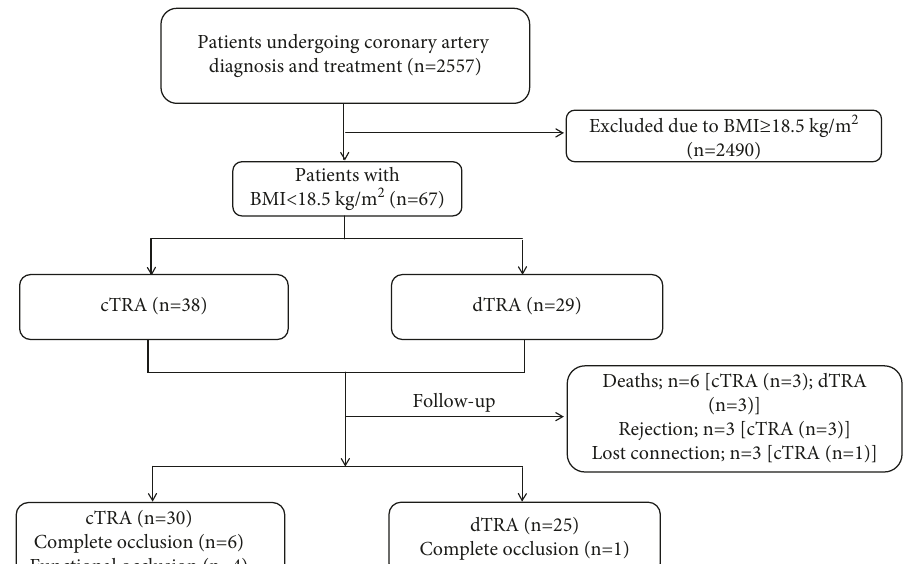
Functional occlusion (n=4)